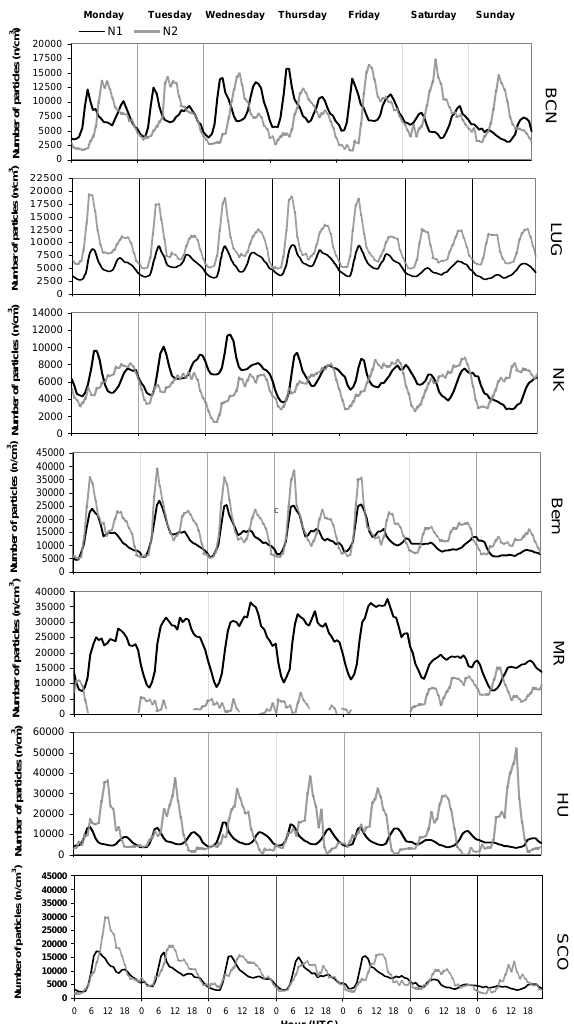
1166 Figure 6. Daily cycle of N1 and N2 for each day of the week 1167 Fig. 6. Daily cycle of: N1 and N2 for each day of the